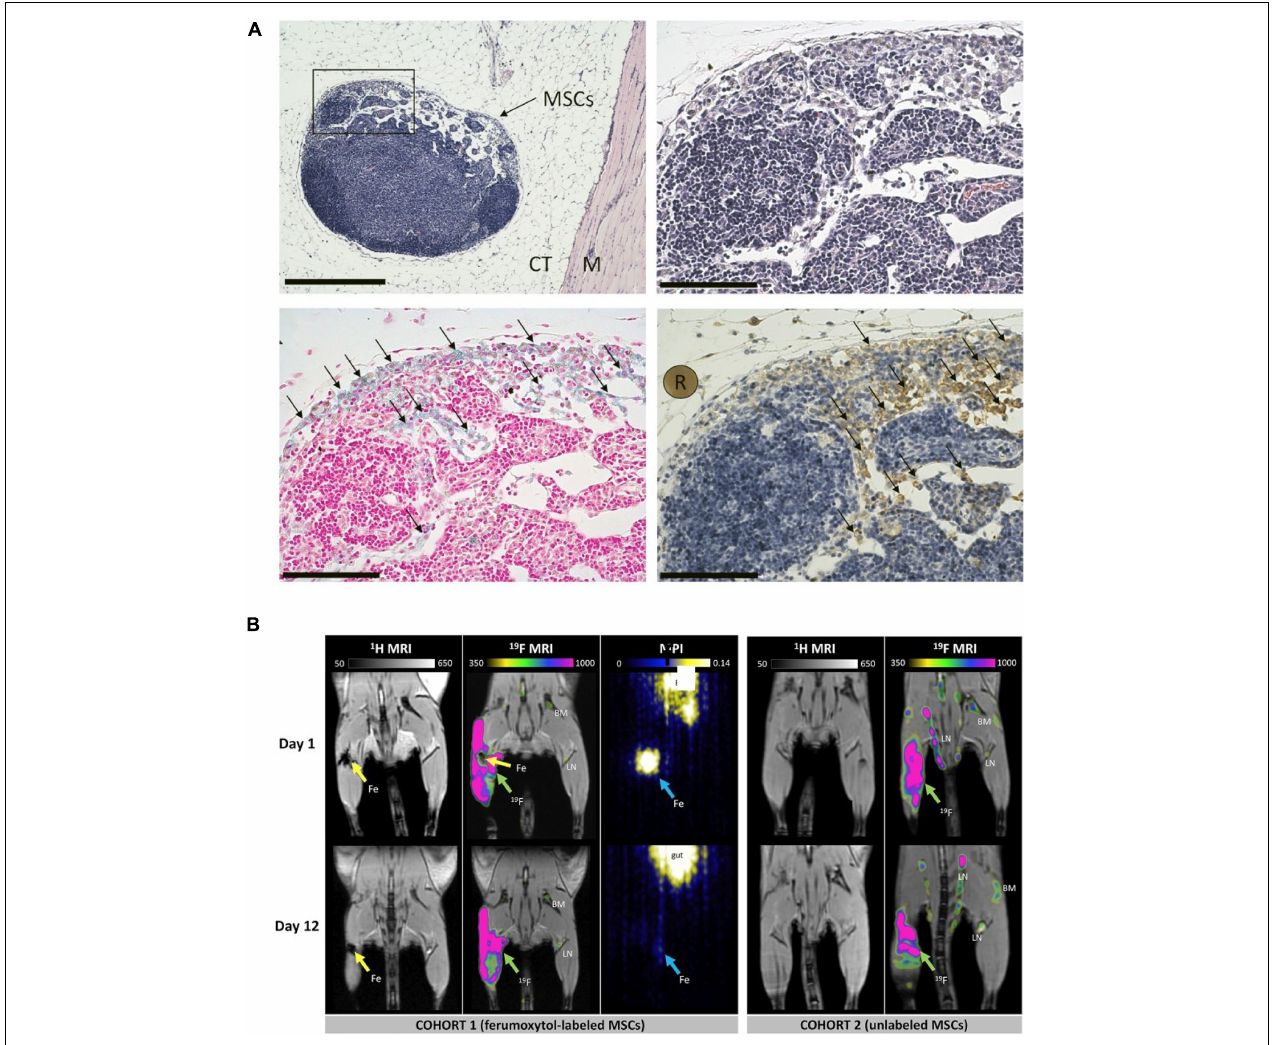
FIGURE 1 | (A) Histological validation showing the presence of MSCs surrounded in connective tissue (CT) and muscle (M) in hematoxylin and eosin at × 10 magnification (scale bar 500 µ m). (B) In vivo proton ( 1 H)/fluorine 19 ( 19 F) magnetic resonance imaging (MRI) and magnetic particle imaging (MPI) (adapted Sehl et al.,